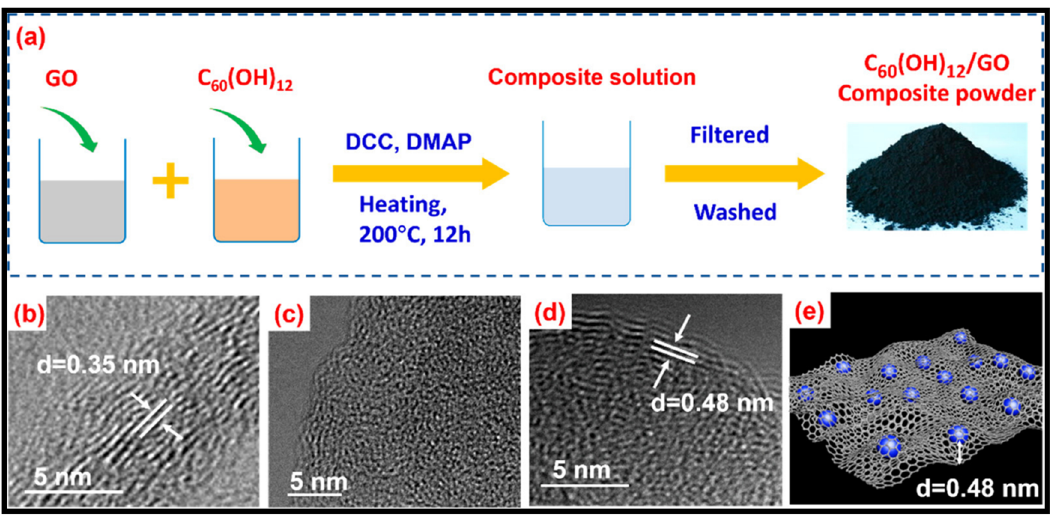
Figure 29: ( a ) Synthetic route for the active material of the LIB anode: the C 60 ( OH ) 12 /GO composite. High - resolution TEM images of ( b ) GO, ( c ) C ( OH ) ( d ) the C ( OH ) d - spacing is found by estimating the distance between the two white lines. 60 12 NPs, and 60 12 /GO composite; the (